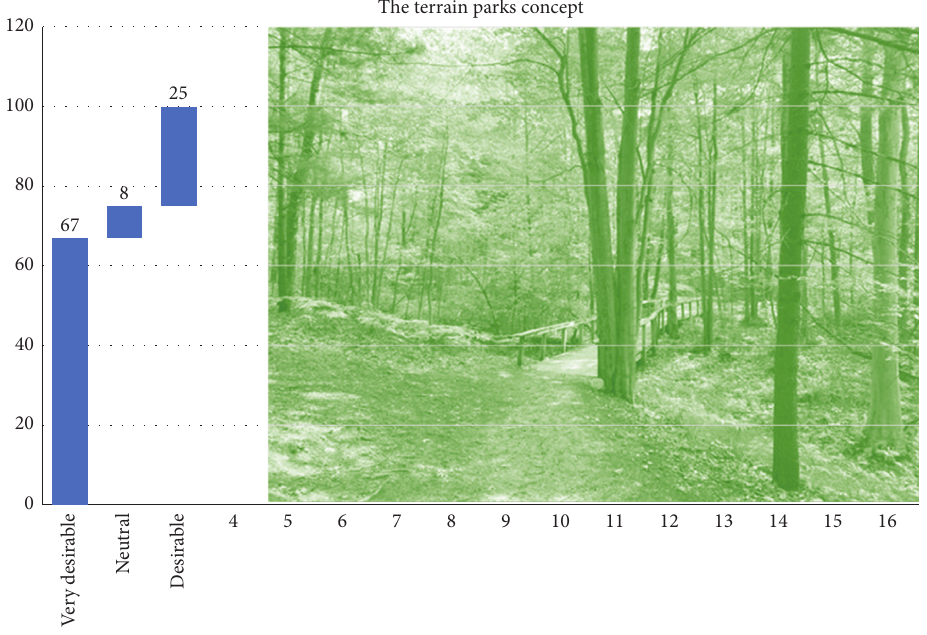
Figure 6: The terrain park concept.